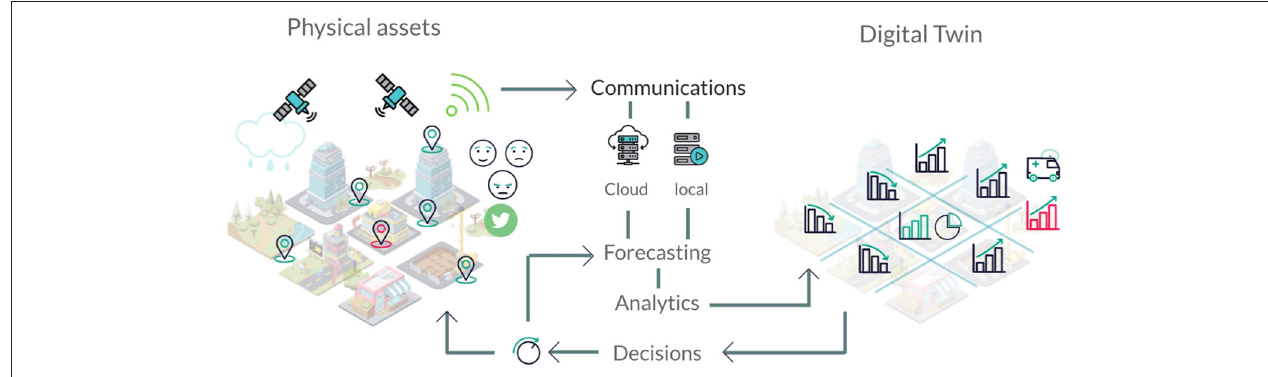
FIGURE 1 | A schematic showing how data generated from physical assets that are used to monitor an urban environment are used to build a virtual counterpart; the Digital Twin. Using a range of forecasting and analytics allows scenario playback and the potential impacts of interventions to be